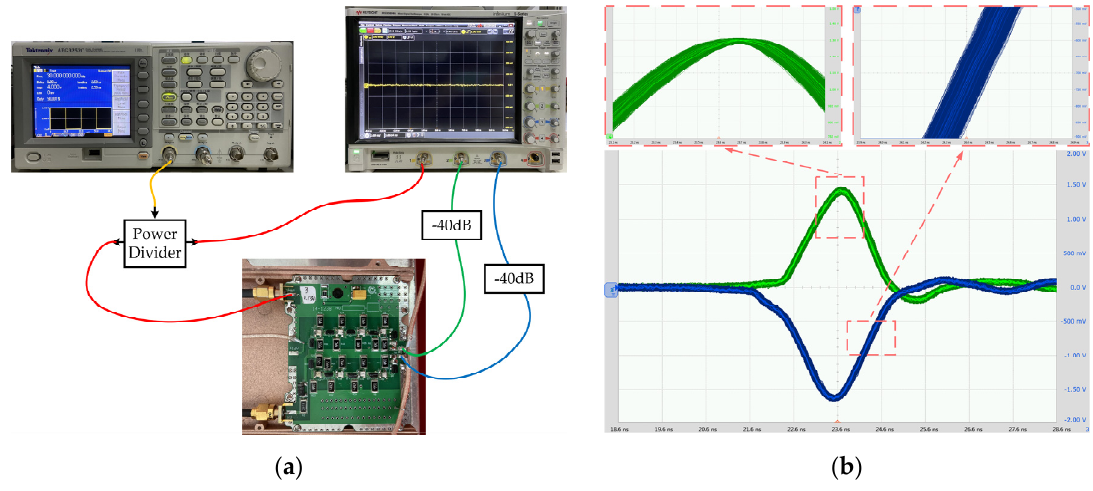
Figure 9. Timing jitter measurement bench and results. ( a ) The measurement bench, and ( b ) the measurement results.